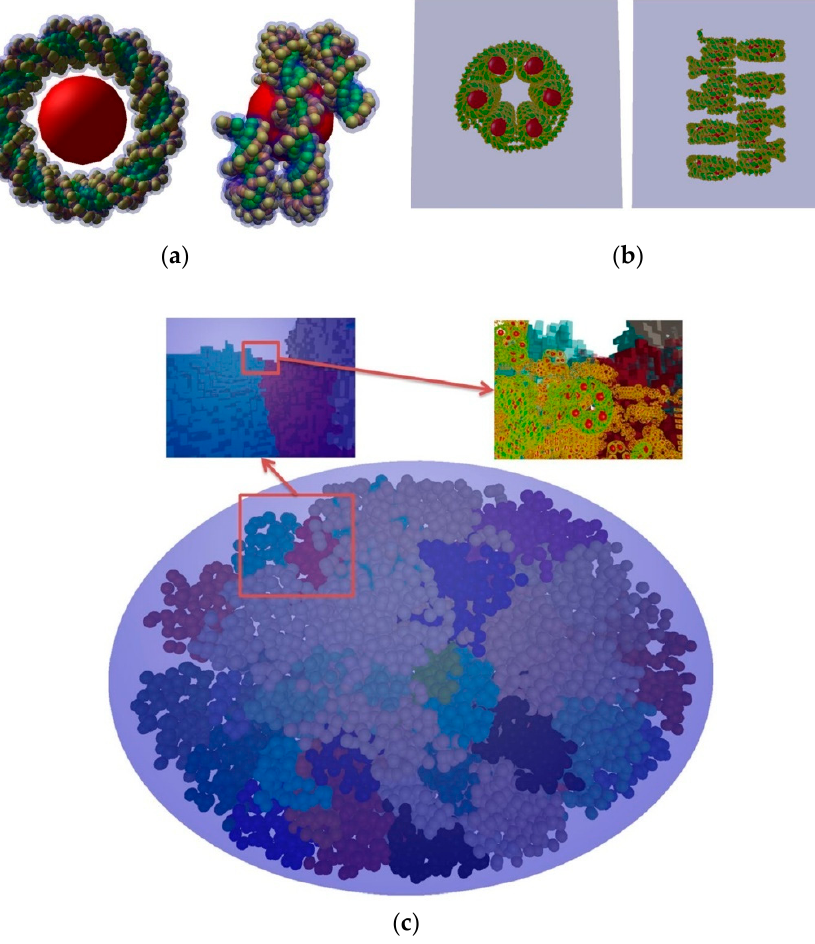
Figure 4. Construction with DNAFabric software of: ( a ) a nucleosome made of B-DNA twisted around a histone, ( b ) a voxel representing a straight voxel of heterochromatin, and ( c ) a fibroblast cell nucleus with different levels of details, taken from [116].